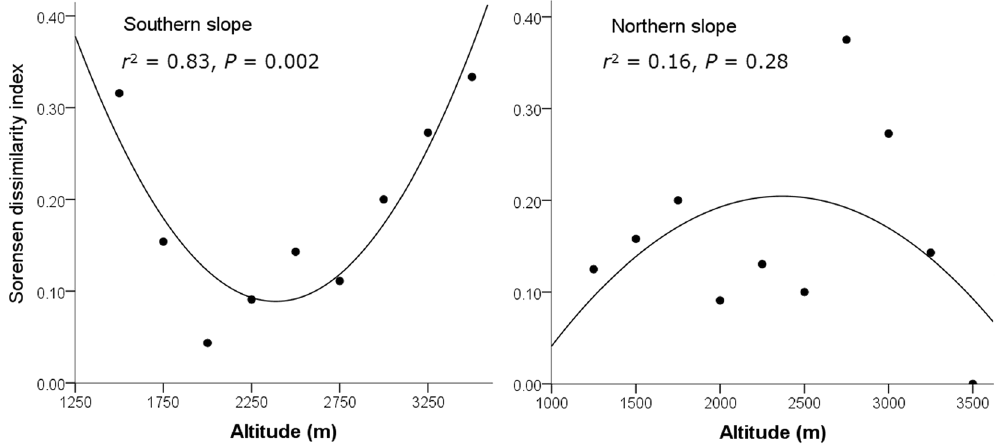
Figure 5. The elevational distribution of the Sorensen dissimilarity index along the southern and northern slopes of Mt. Taibai. The results of the polynomial regressions are presented.